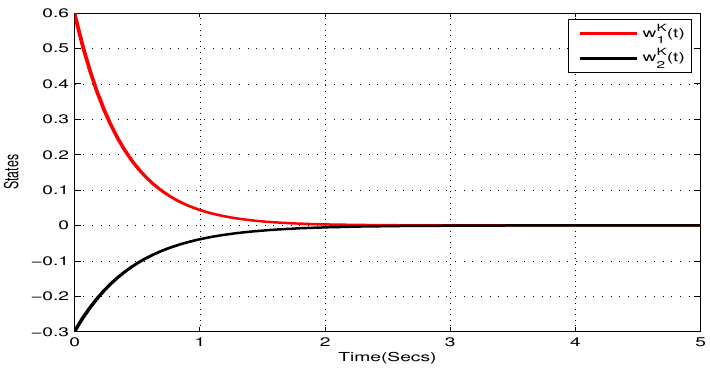
Figure 4. State trajectory of w K